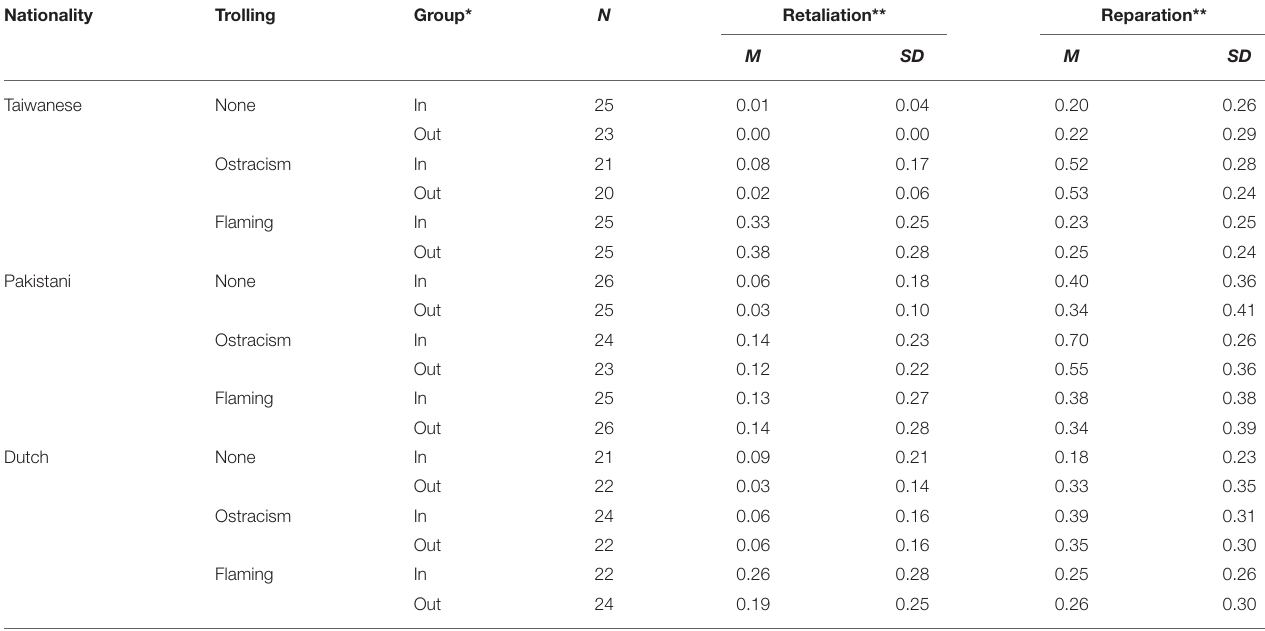
TABLE 3 | Descriptive statistics of participants’ behavioral responses to trolling. Nationality